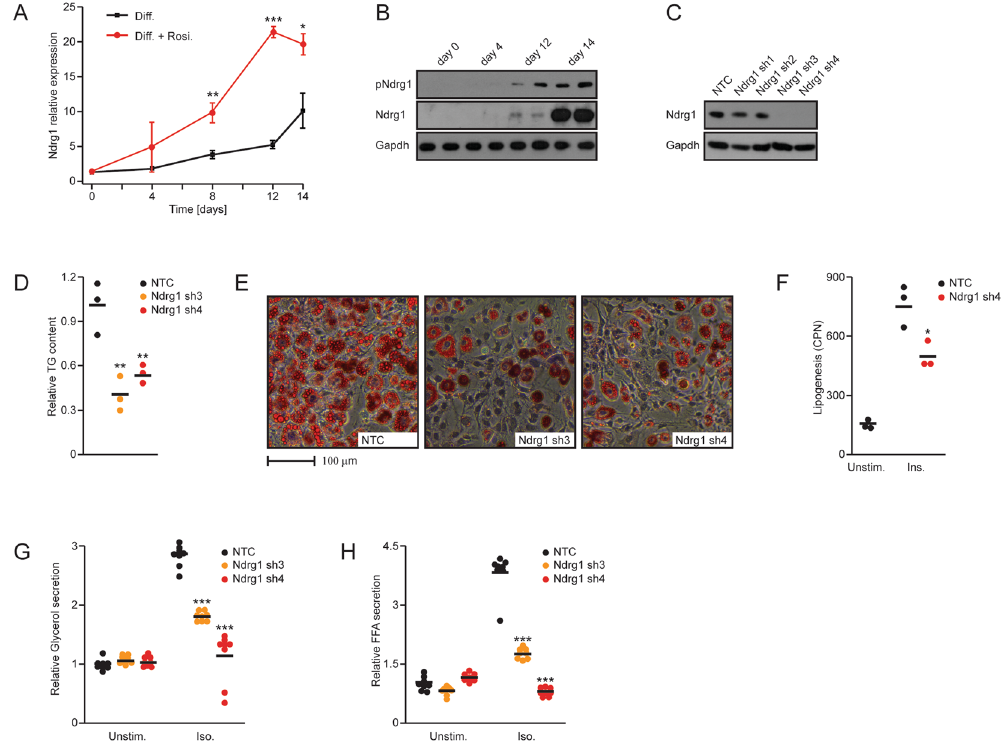
Figure 1. Ndrg1 promotes adipocyte differentiation and lipolysis. ( A ) Expression of Ndrg1 mRNA in 3t3l1 cells at different stages of differentiation with or without rosiglitazone (Rosi). Stars indicate significance between expression levels in control and Rosi-treated cells at the specific time points ( * P < 0.05, ** P < 0.01, *** P < 0.001 according to a t-test). ( B ) Total and phospho-Ndrg1 levels at different stages of 3t3l1 differentiation. ( C ) Ndrg1 protein levels in cells targeted by different shRNAs against Ndrg1 (Ndrg1 sh). ( D ) Relative TG content and ( E ) neutral lipid staining (OilRedO) on differentiated 3t3l1 cells after knockdown of Ndrg1. ( F ) Lipogenesis rate in control and Ndrg1 sh cells, unstimulated (unstim.) or upon insulin (Ins.) stimulation. ( G ) Relative glycerol and (H) FFA levels in medium from differentiated 3t3l1 control cells or Ndrg1 knockdown cells stimulated with control medium or isoproterenol (Iso). For all graphs, each data point represents a biological replicate. Stars indicate significance for given parameters between control and Ndrg1-depleted cells. ( * P < 0.05, ** P < 0.01, *** P < 0.001 according to ANOVA followed by the Post hoc Tukey